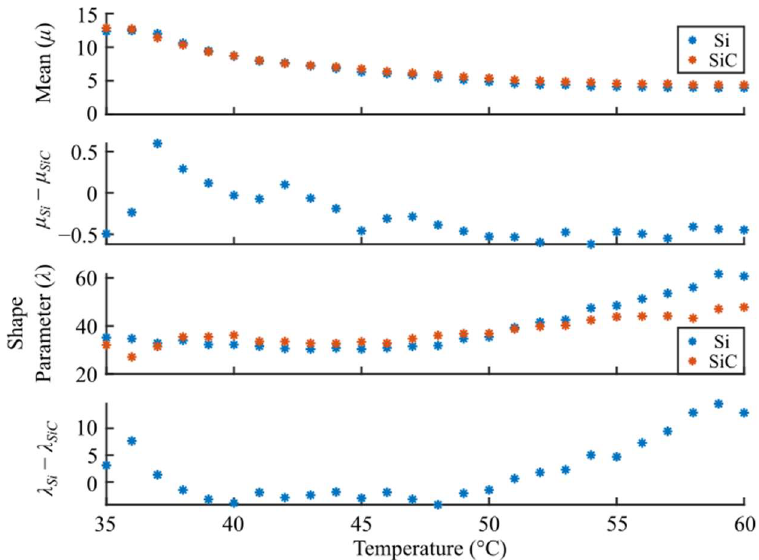
Figure 20. Mean and shape parameters of the shaft breakdown voltage inverse Gaussian distributions plotted against temperature.